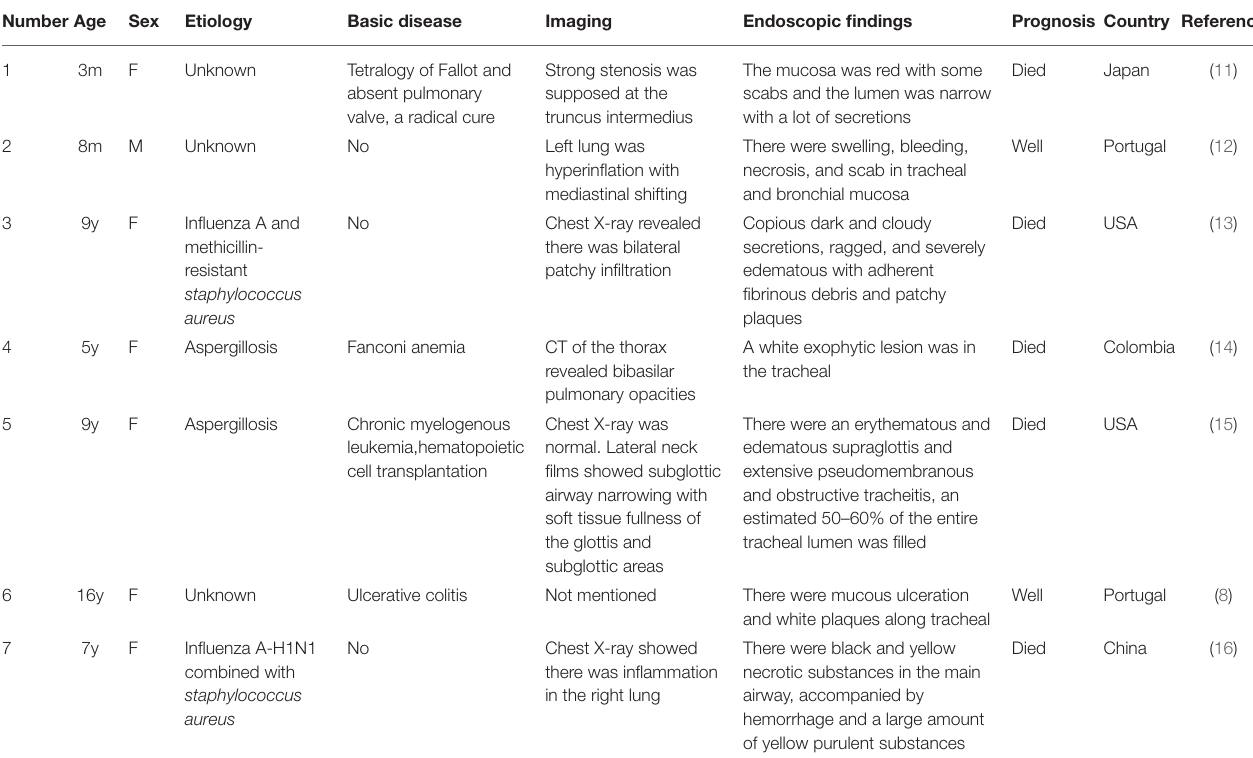
TABLE 1 | Cases of children with necrotizing